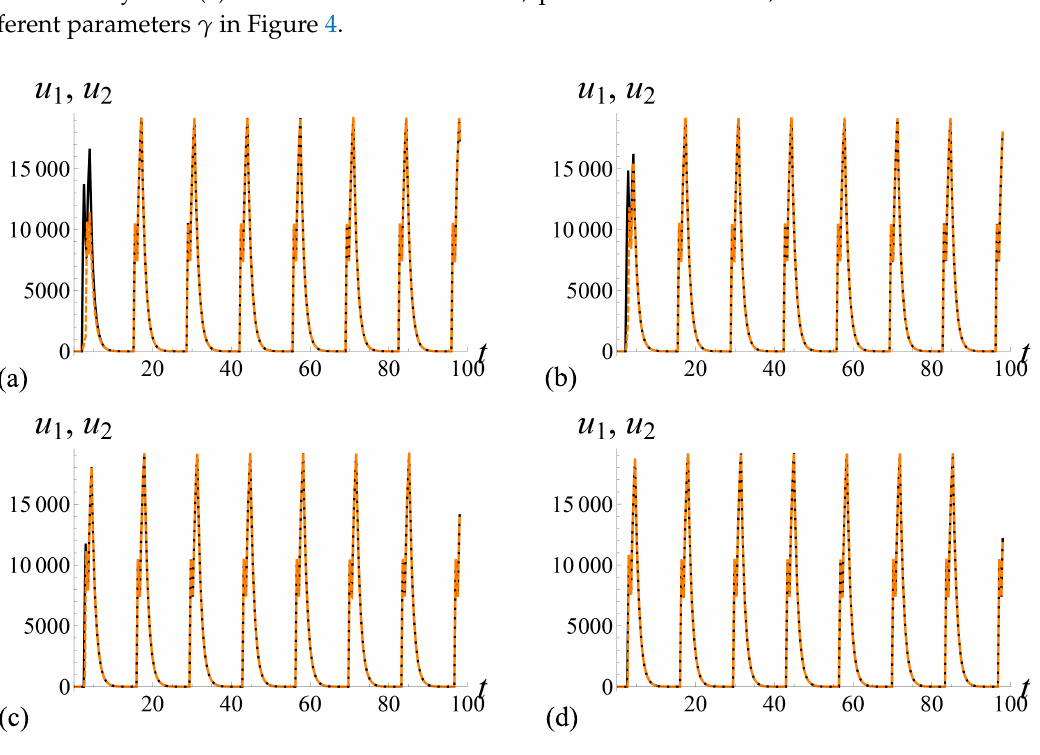
Figure 4. Solutions of system (3) for different values of parameter γ . Values of parameters: T = 2, p = 1.5, λ = 1000, k = 1, x = 3, ( a ) γ = 0.2; ( b ) γ = 0.6; ( c ) γ = 1; ( d ) γ = 1.5. Black line— u 1 ( t ) , orange dashed line— u 2 ( t )